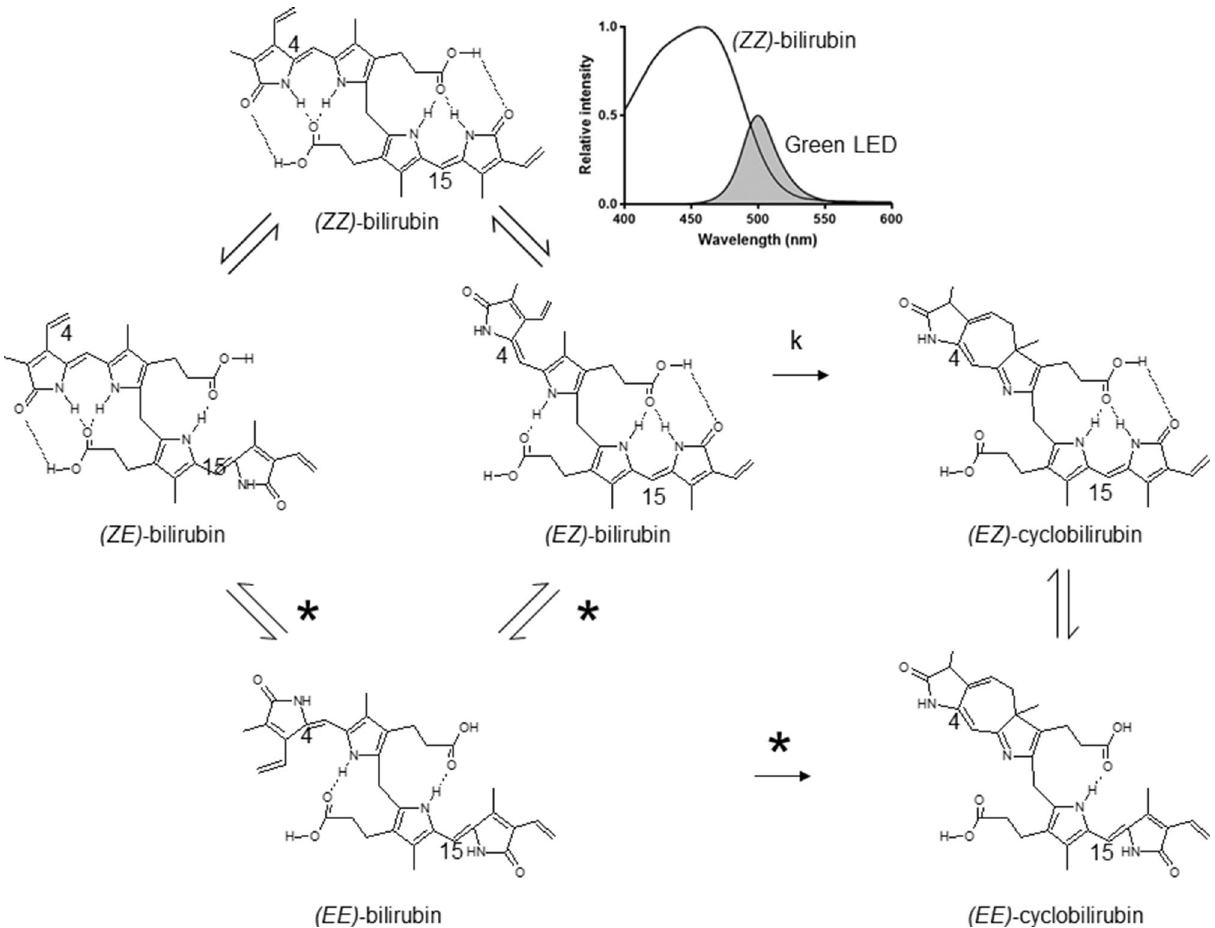
Figure 4. The structure and photochemical reactions of bilirubin and its photoisomers. The relative spectra represent the absorption spectrum of (ZZ) -bilirubin-human SA solution [phosphate buffer (pH 7.4)] and the irradiation spectrum of the green LEDs. The asterisk (*) indicates a theoretical